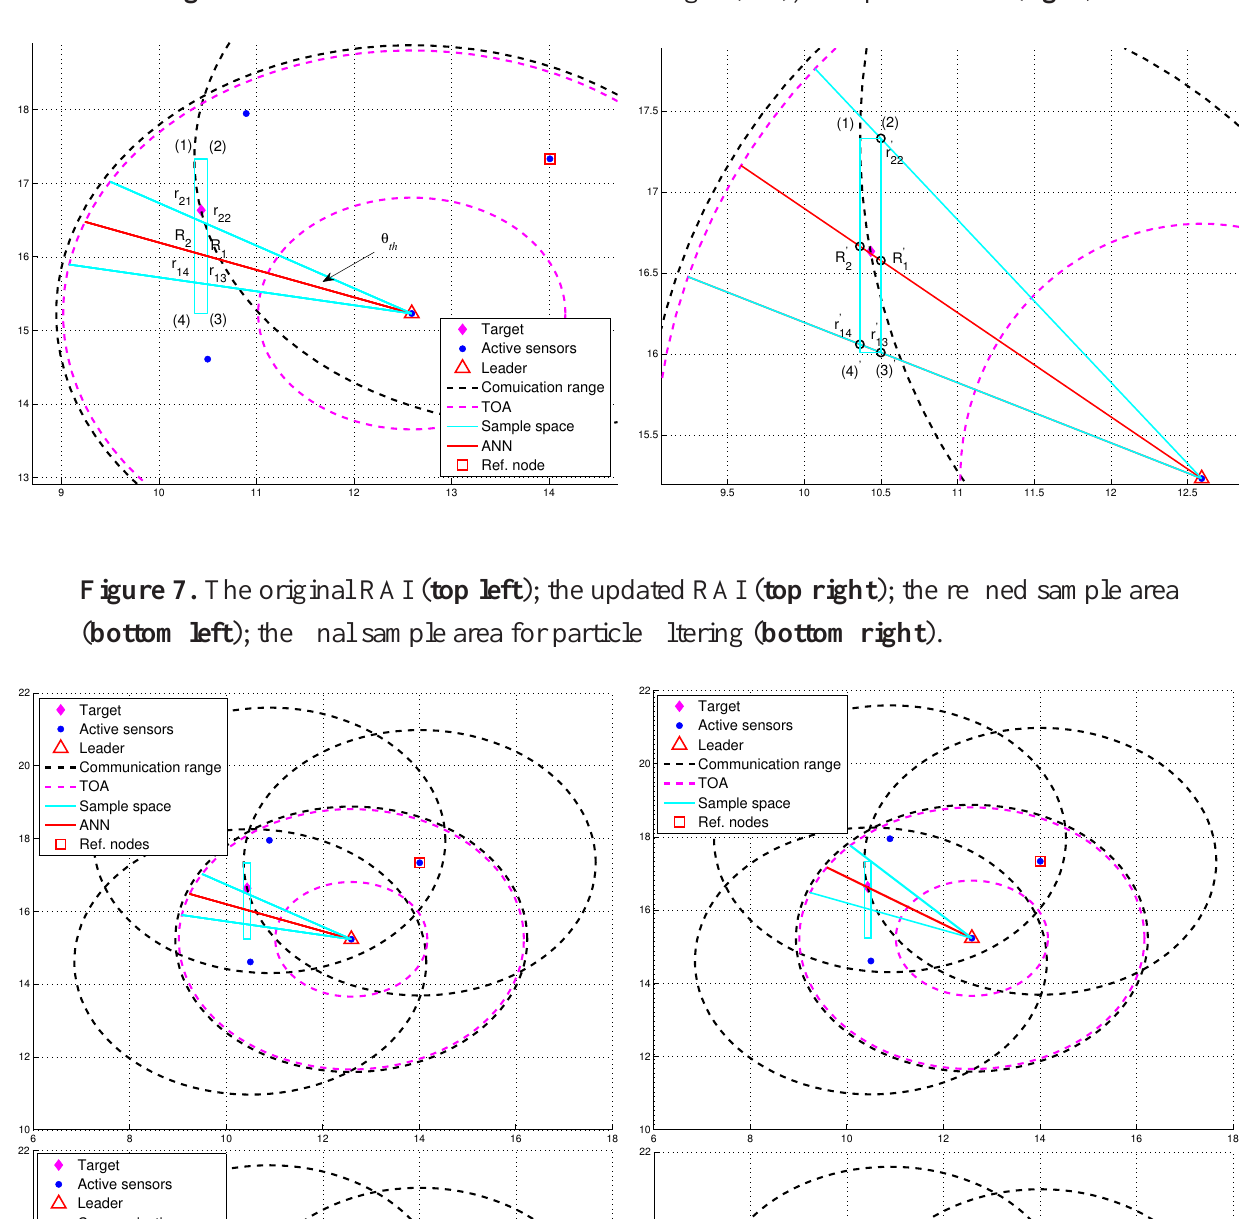
Figure 6. The deviation of RAI from the target ( left ); the updated RAI ( right ).